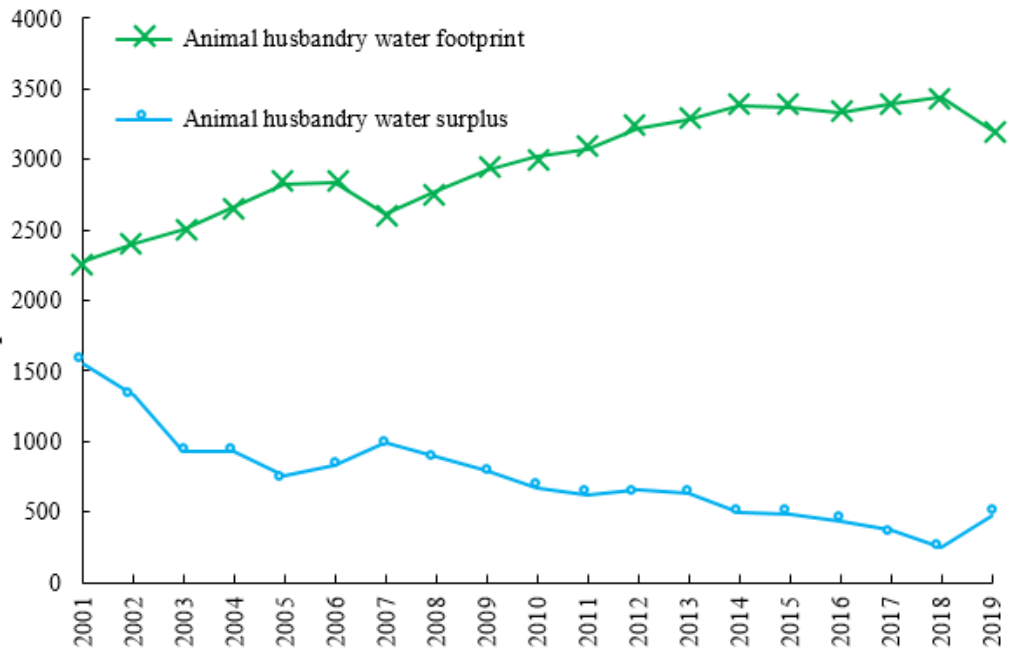
Figure 2. Changes in the animal husbandry water footprint and water surplus in China.